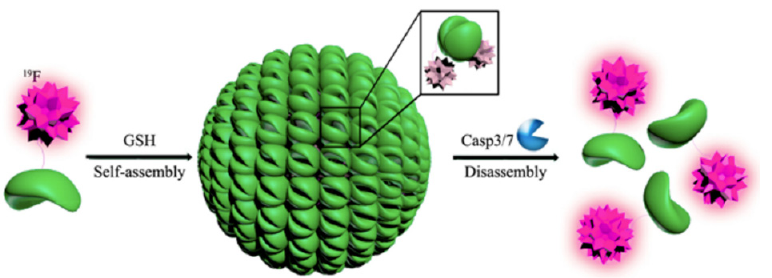
Figure 17. Schematic illustration of GSH-controlled self-assembly to turn 19 F NMR signals “off” and Casp3/7-controlled disassembly of 19 F NPs to turn 19 F NMR signals “on”. Figures adapted with permission [105]. Copyright 2015 American Chemical Society.